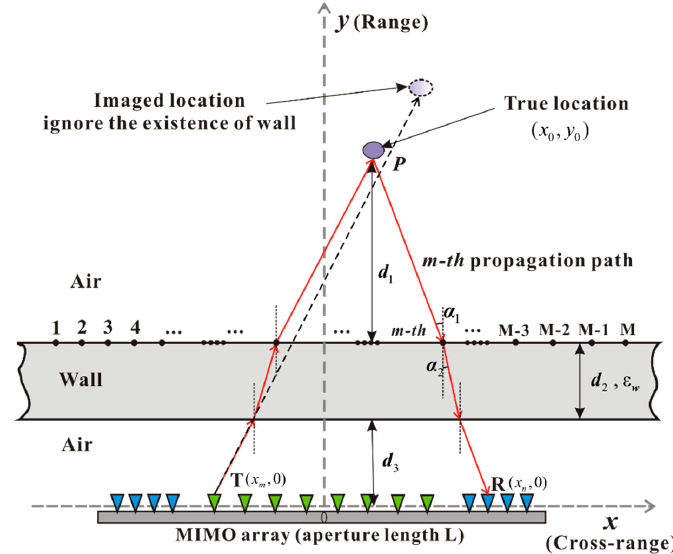
Figure 12. Imaging geometry for through-wall radar (TWR) with the designed MIMO array.